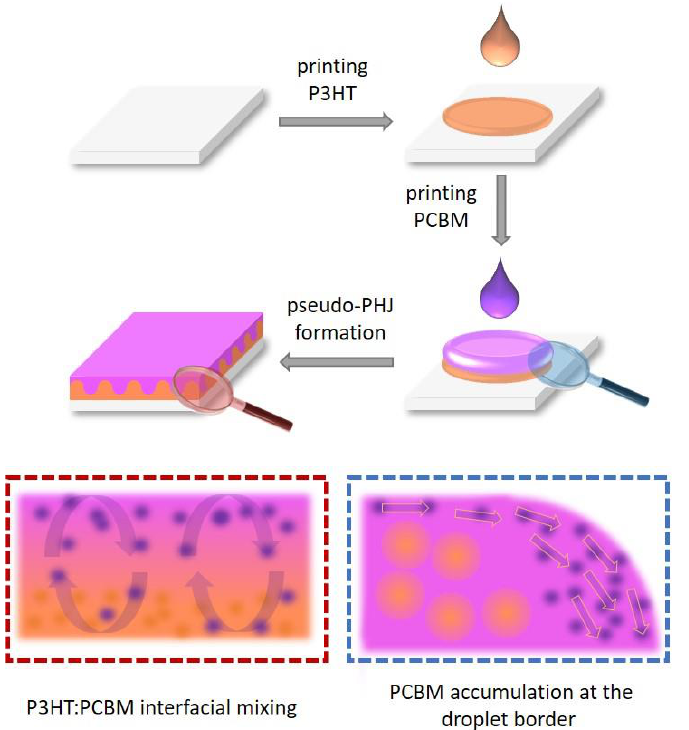
Figure 6. The interplay of interfacial mixing and Marangoni flows in sequentially printed quasi-miscible droplets. The sequential printing of quasi-miscible droplets leads to interfacial mixing of the PCBM molecules to obtain a quasi-complete mixing with the P3HT-printed layer at microsecond time scales. PCBM molecules are accumulated at the droplet border due to the chlorobenzene-driven Marangoni flows.